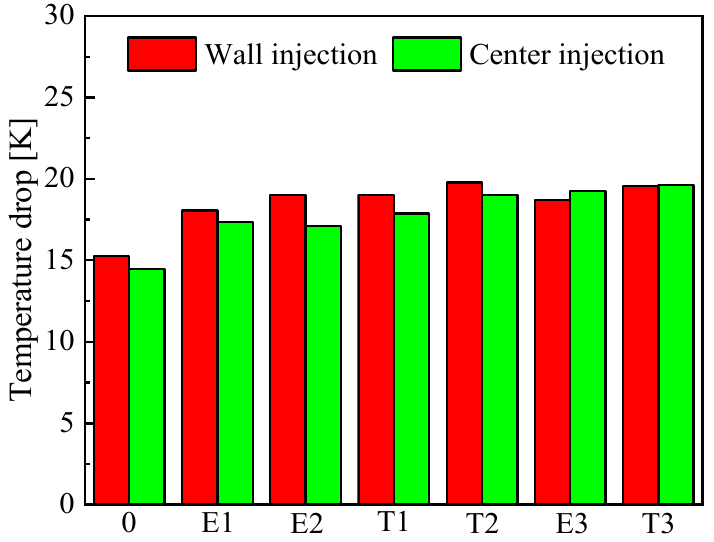
Figure 9. The average reduced temperature of exhaust gas.